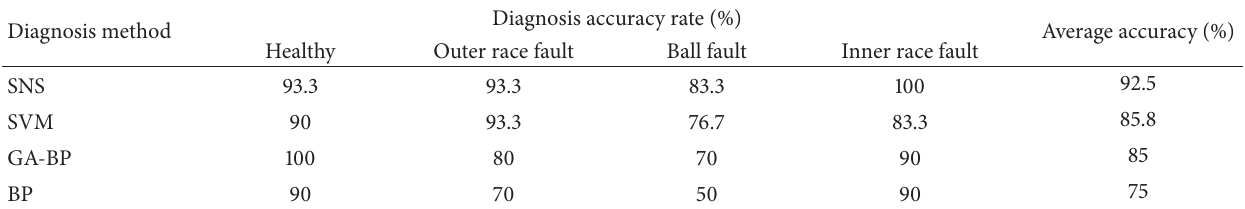
Table 6: Fault diagnosis results based on the correlation coefficient of SNSs, SVM, BP, and